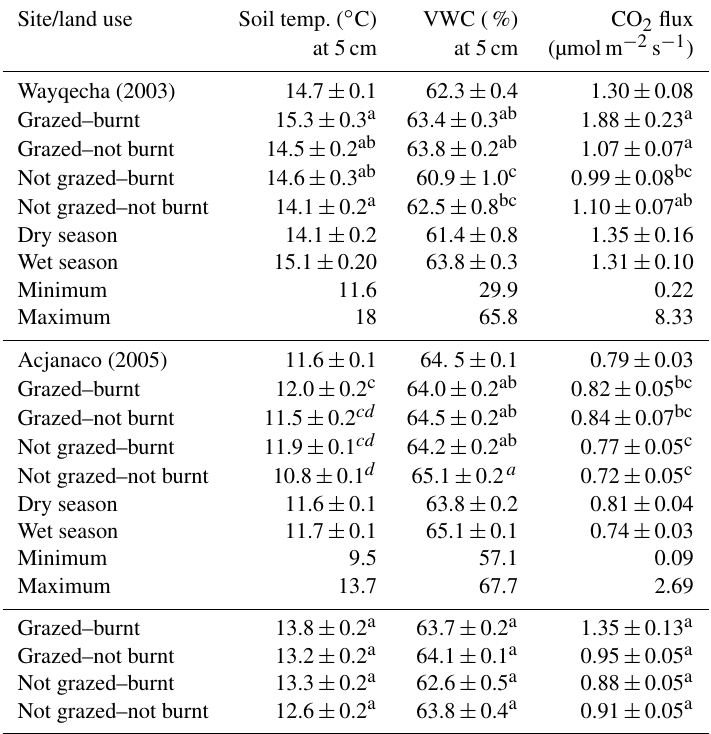
Table 2. Annual and seasonal mean soil temperature, VWC, and CO 2 flux for Wayqecha and Acjanaco for each land management system. Different letters down the columns represent significant differences between